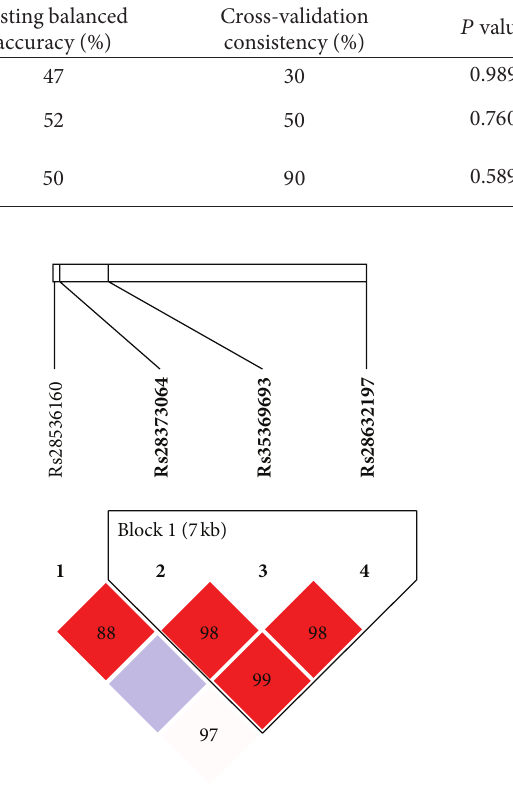
Figure 3: Relative positions and LD estimates between CRHR1 polymorphisms in the analyzed population. Coloured squares cor- respond to 𝐷 󸀠 values with numerical estimates given within the